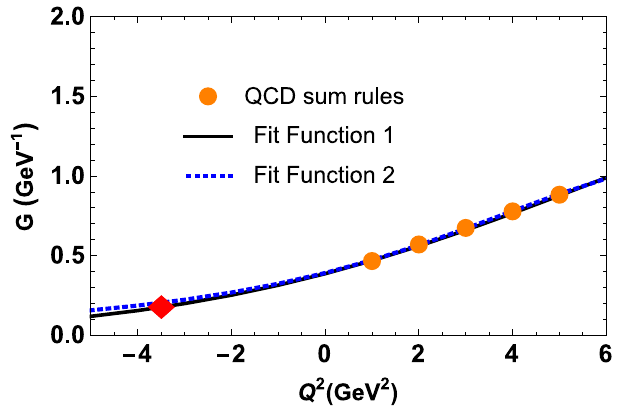
Figure 3 . The sum rule results and functions F ( Q 2 ) (FF 1) and F ( Q 2 ) (FF 2) for the strong coupling G ( Q 2 ) . The red diamond fixes the point Q 2 = − m 2